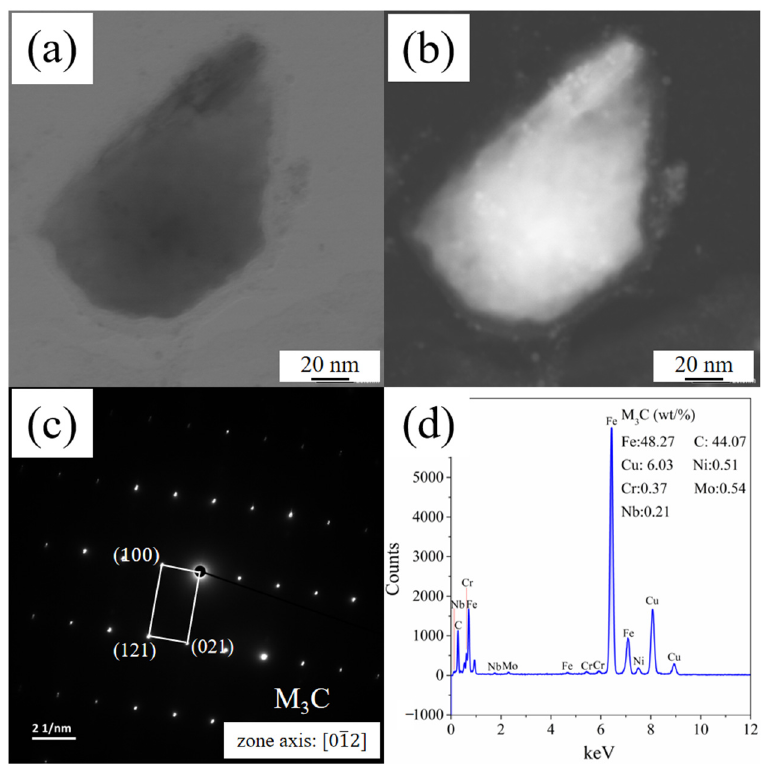
Figure 11. ( a ) TEM. ( b ) Dark field micrographs. ( c ) SAED patterns and ( d ) EDS of Fe 3 C carbides in 3.5 Ni steel.